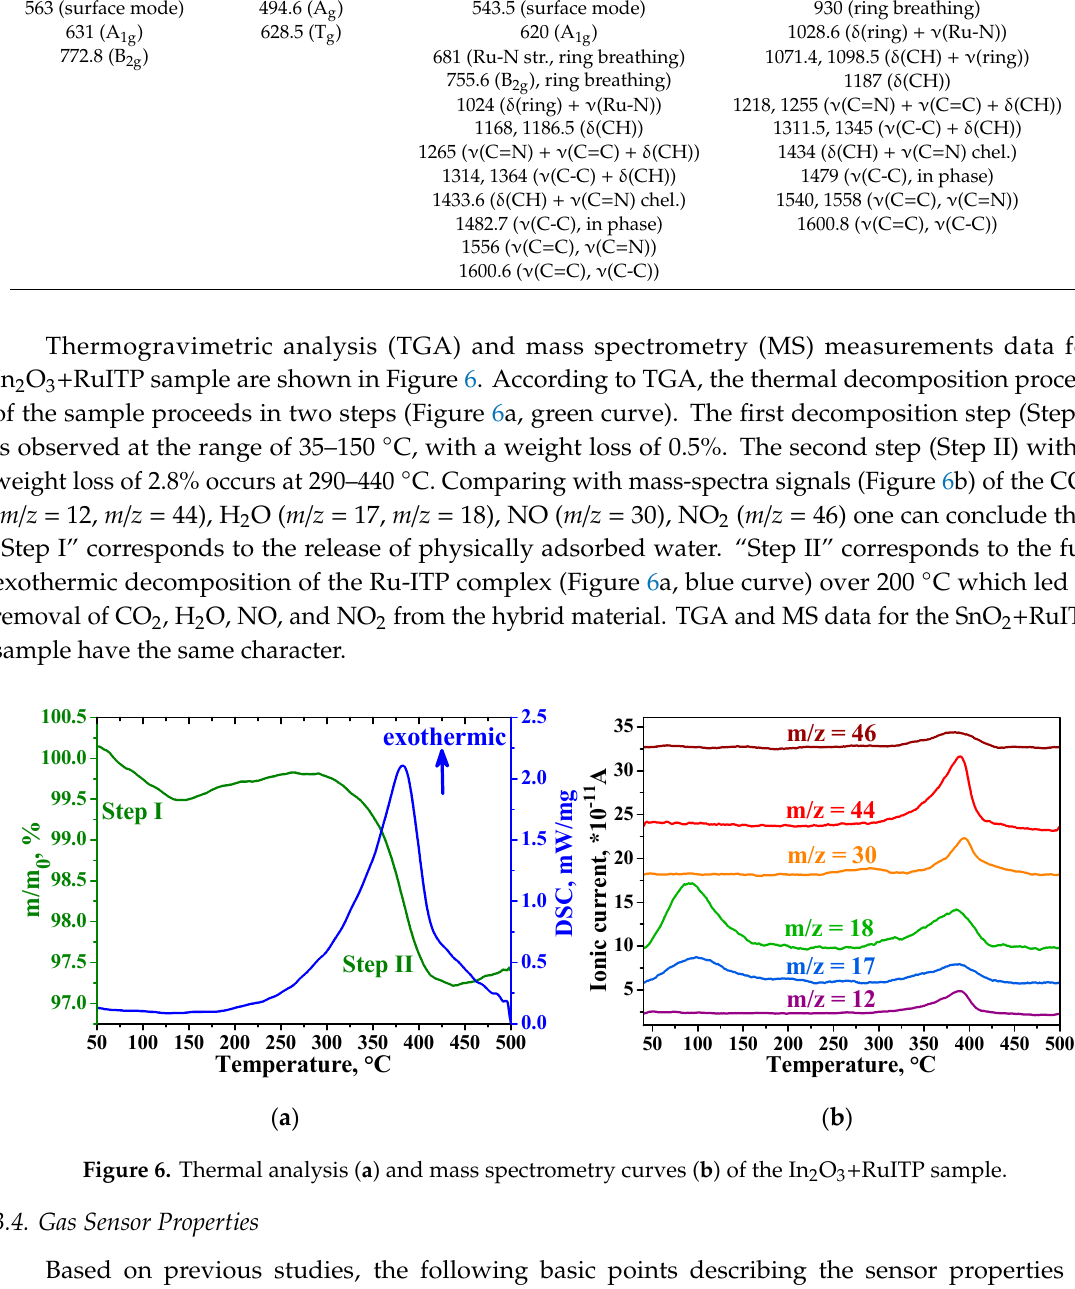
Figure 6. Thermal analysis ( a ) and mass spectrometry curves ( b ) of the In 2 O 3 +RuITP sample.